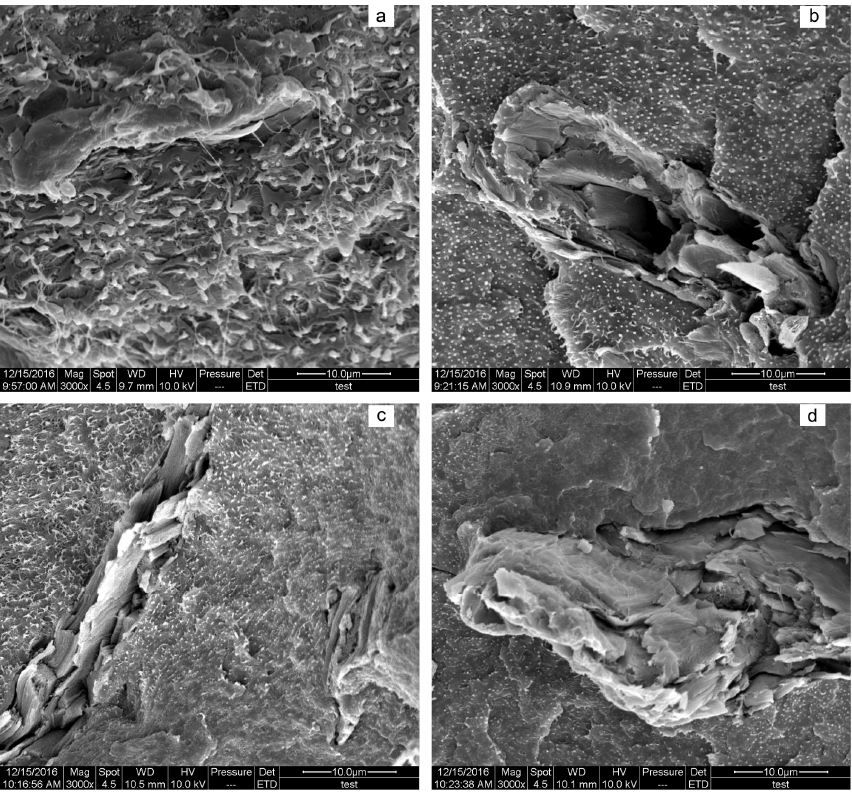
Figure 6. Morphologies of the composites in various MAPE contents: ( a ) 5%; ( b ) 10%; ( c ) 15%; and ( d ) 20%.